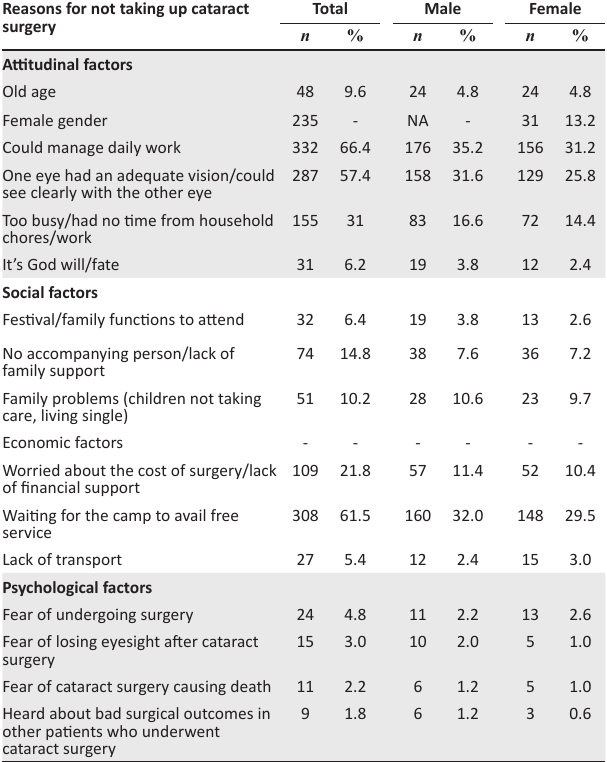
FIGURE 2: Reasons for uptake of cataract surgery in current